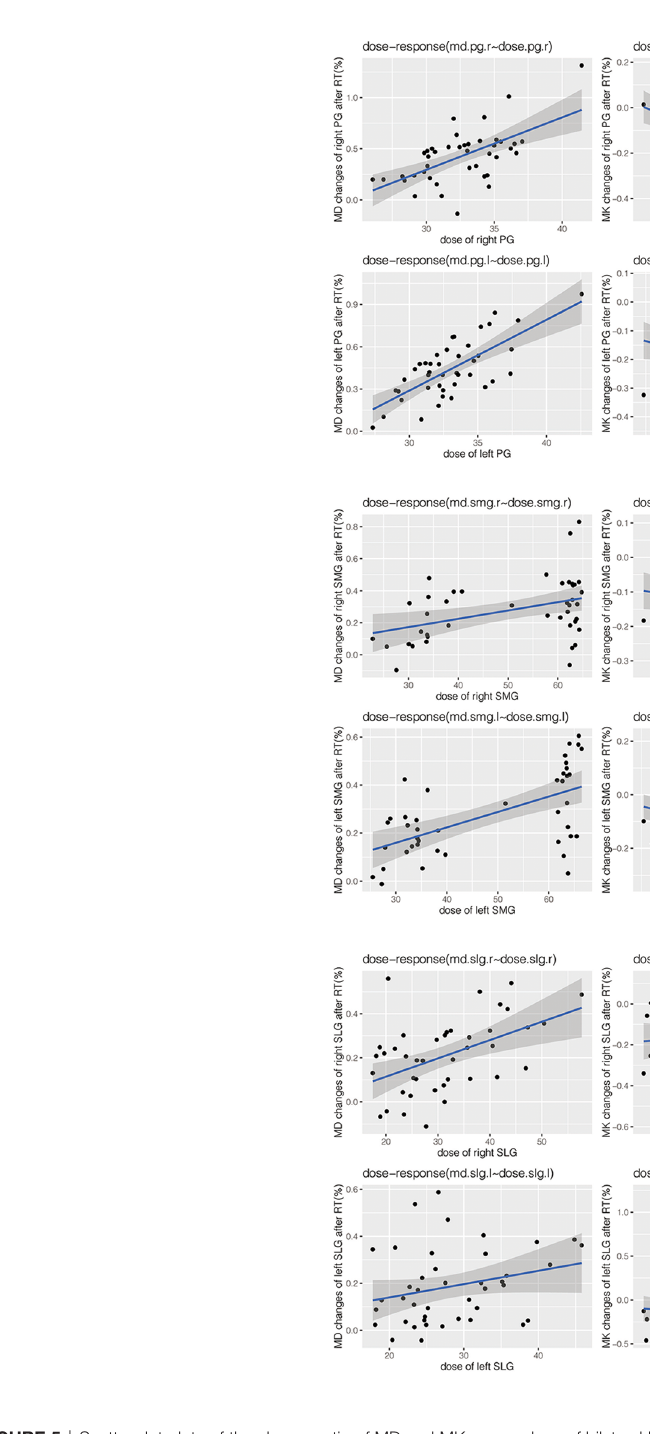
FIGURE 5 | Scatter dot plots of the change ratio of MD and MK versus dose of bilateral PGs, SMGs, and SLGs. Abbreviations are referred to in Table 2